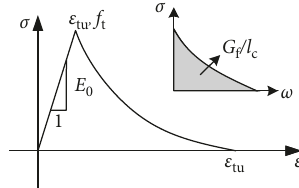
Figure 4: Tensile stress-strain curve of concrete.